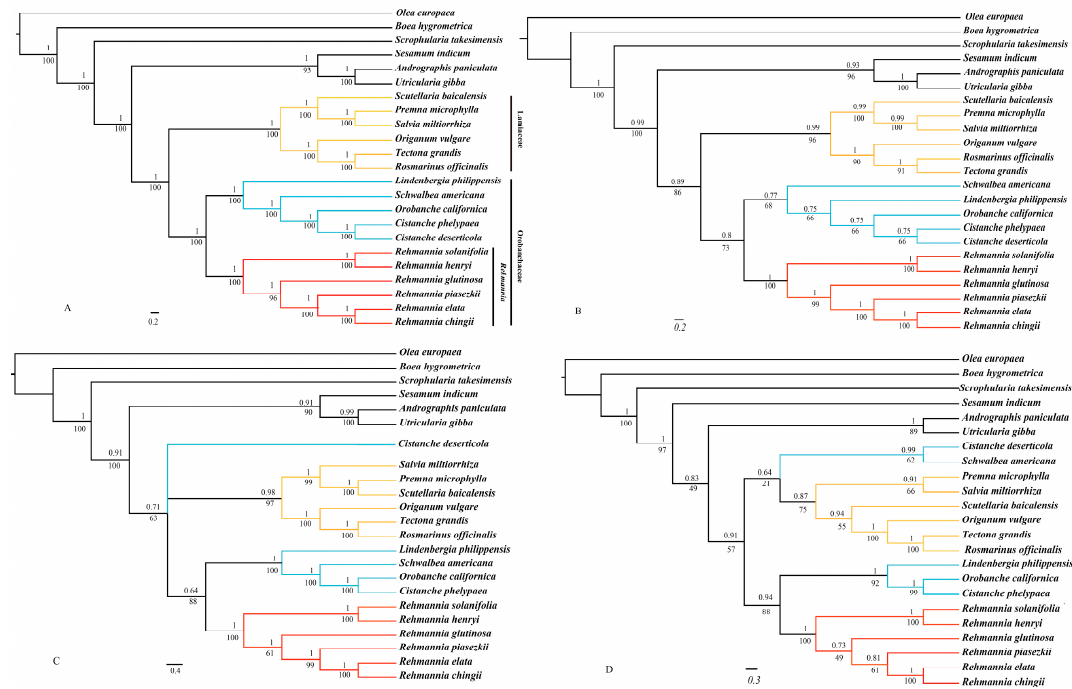
Figure 6. Phylogenetic trees of 23 species as determined from different data partitions. Support values are shown for nodes as Bayesian inference posterior probability (above branches)/maximum likelihood bootstrap (below branches). Branch lengths were calculated through Bayesian analysis, and scale bar denotes substitutions per site. ( A ) the whole chloroplast genomes; ( B ) Protein coding genes; ( C ) LSC region; ( D ) SSC region. Red represents Rehmannia species; Blue represents other species of Orobanchaceae; Orange represents Lamiaceae species .